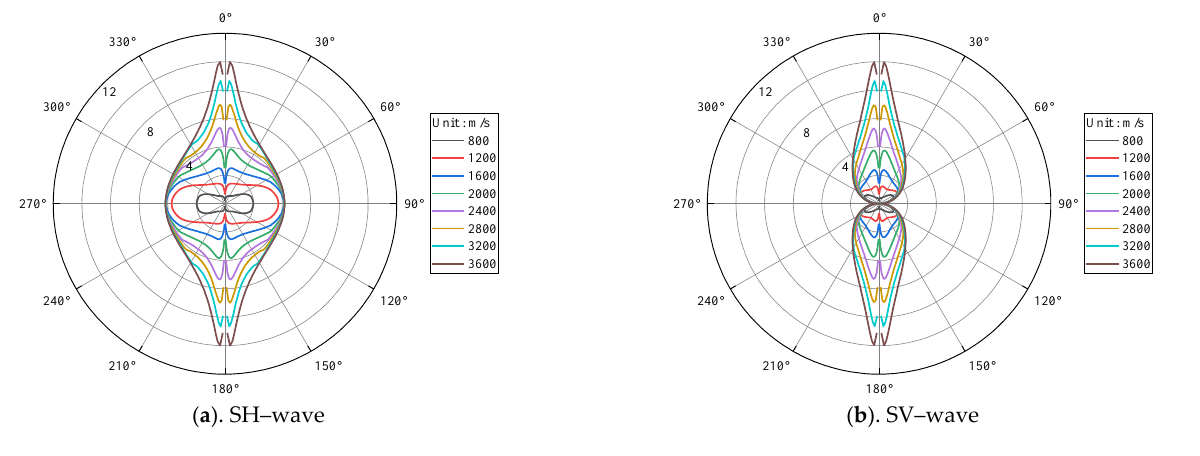
Figure 6. Radiation characteristics of SH – wave and SV – wave of a dipole source under different formation shear velocities.